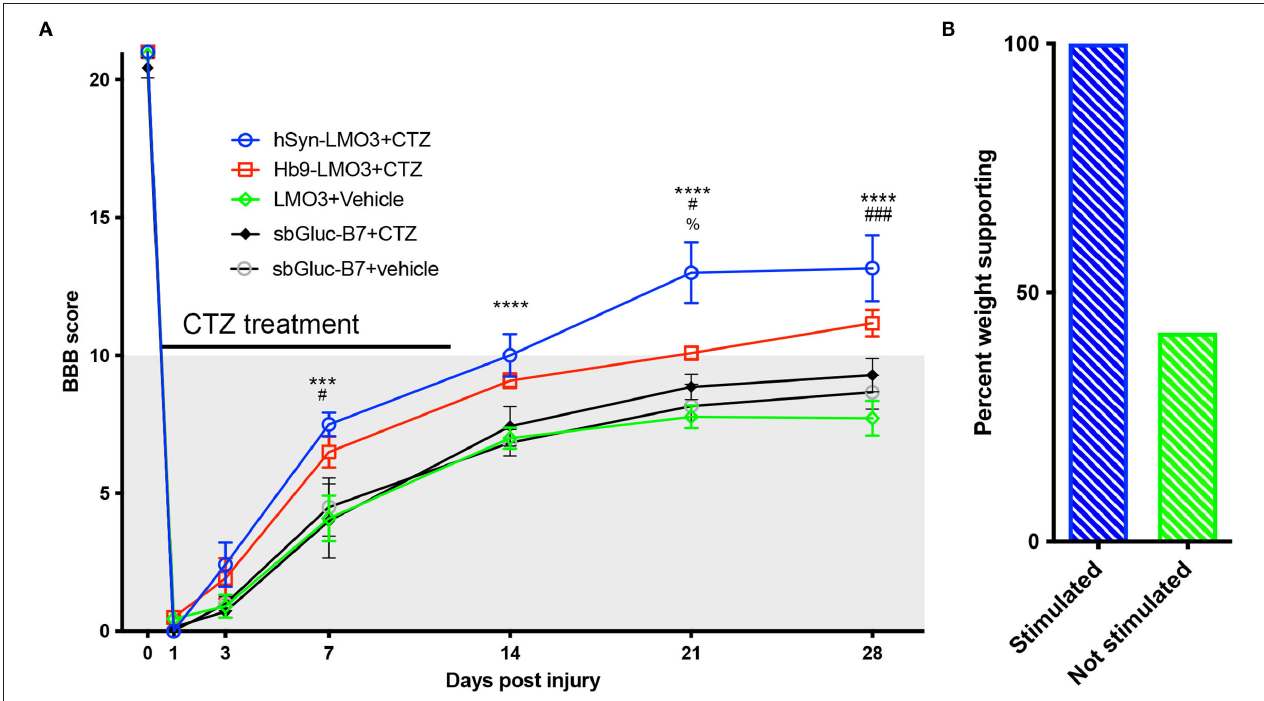
FIGURE 3 | Accelerated and enhanced locomotor recovery with BL-OG. (A) BBB locomotor scores following injury and treatment for animals expressing LMO3 in neurons (hSyn) or specifically in motor neurons (Hb9) or expressing just the luciferase in neurons (sbGLuc-B7). Animals received either CTZ or vehicle following injury. Those which received neural stimulation regardless of neuronal subpopulation (hSyn-LMO3 + CTZ, Hb9-LMO3 + CTZ) recovered at a faster rate, to a greater extent, and maintained their status following the treatment period compared to the non-stimulated vehicle treated group (LMO3 + veh) as well as the groups expressing only the luciferase. For Bonferroni post-hoc : hSyn-LMO3 + CTZ vs vehicle * p < 0.05, ** p < 0.01, *** p < 0.001, **** p < 0.0001; Hb9-LMO3 + CTZ vs. vehicle # p < 0.05, ## p < 0.01, ### p < 0.001; hSyn-LMO3 + CTZ vs. Hb9-LMO3 + CTZ; % p < 0.05. n = 6 for hSyn-LMO3 + CTZ, n = 6 for Hb9-LMO3 + CTZ, n = 11 for vehicle treated animals. Animals expressing the luciferase only were not significantly different from the vehicle treated controls. (B) Comparison of the percentage of weight supporting animals at the endpoint (28 days) for those that received BL-OG stimulation (hSyn-LMO3 + CTZ, Hb9-LMO3 + CTZ) compared to all three control groups (LMO3 + veh, sbGluc-B7 + CTZ, sbGluc-B7 +